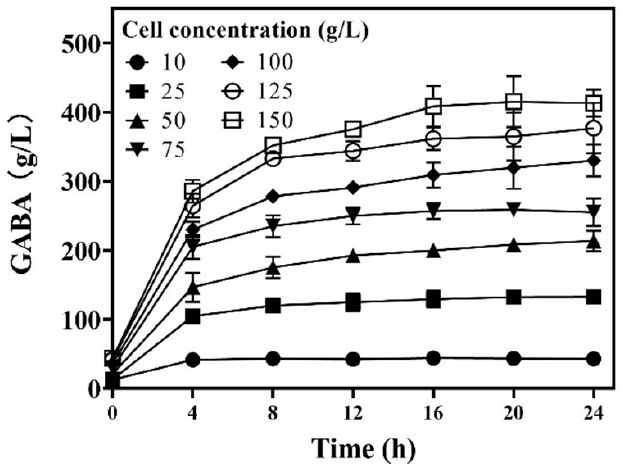
Figure 4. Effects of cell concentration on GABA production. GABA was determined using the HPLC method ( n = 3).